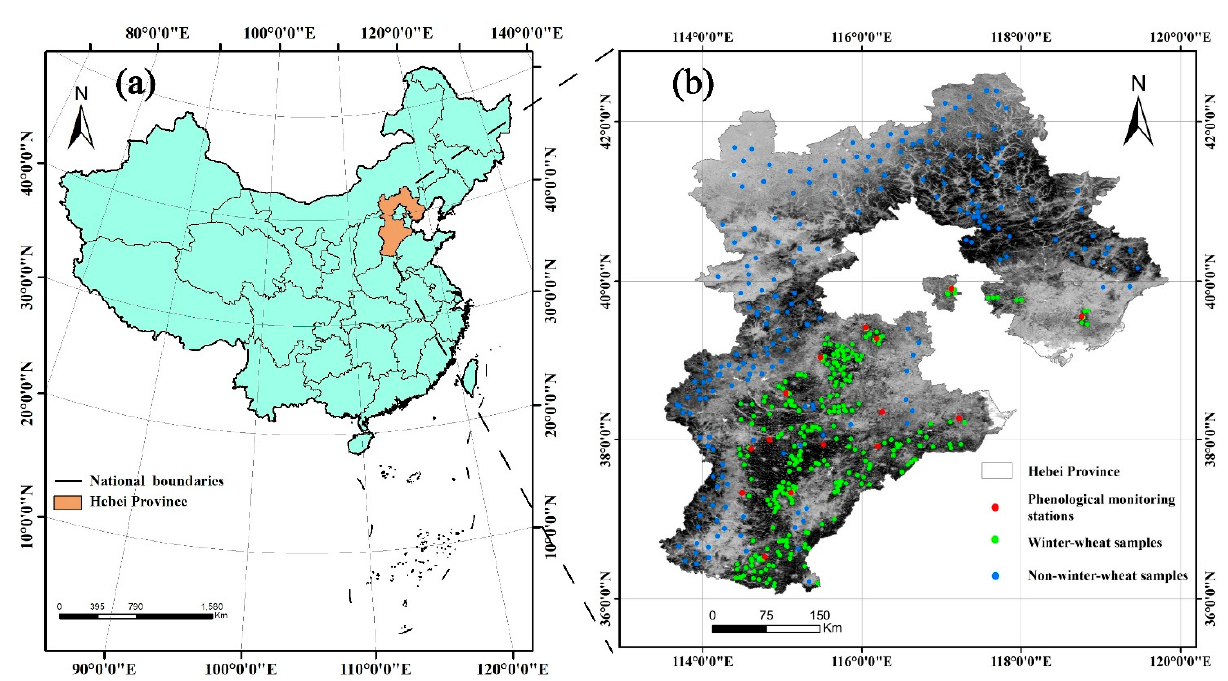
Figure 1. ( a ) The location of the study area. ( b ) Phenological monitoring stations (red) and field data.